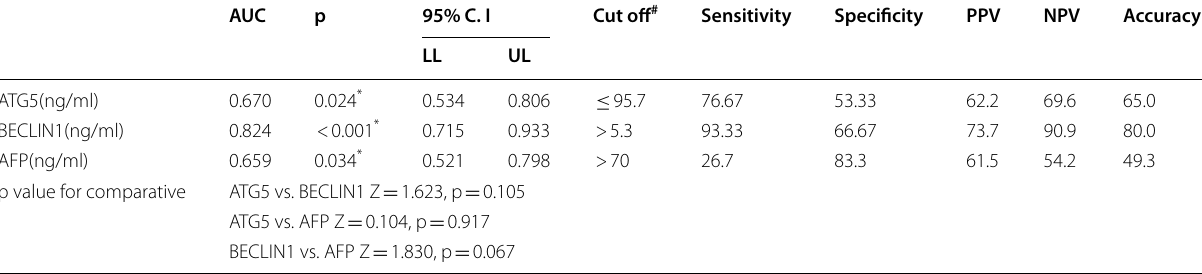
Table 7 Agreement (sensitivity, specificity) for ATG5, BECLIN1 and AFP to diagnose HCC patients from Cirrhotic